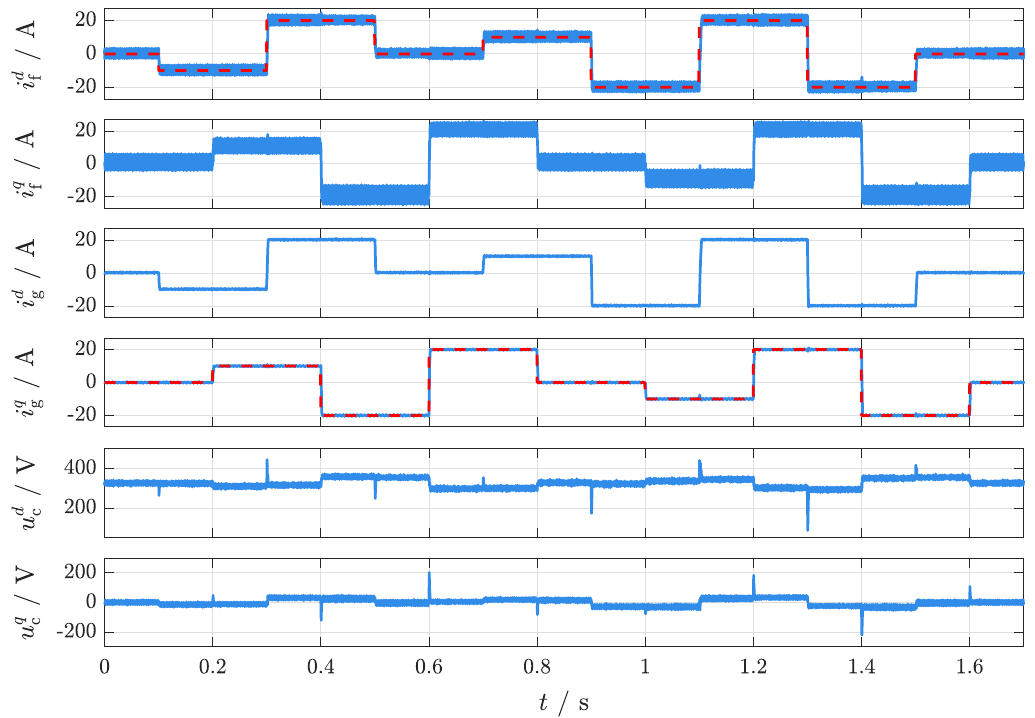
Figure 4. Simulative results of the discrete linear-quadratic regulator (DLQR) Current Controller with integral feedback. [Color code: reference currents i d and i q ]. f,ref g,ref